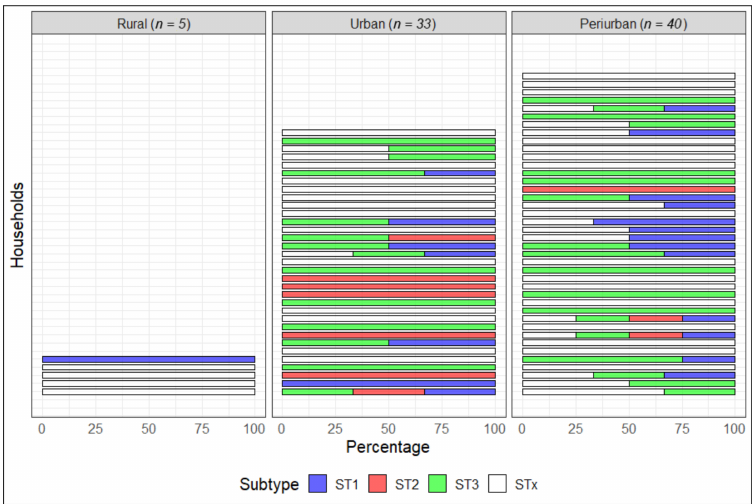
Figure 3. Distribution and composition of Blastocystis subtypes per household and study area. * STx: unknown Blastocystis subtype. n corresponds to the number of households that participated in each study area and not the number of participants. The samples came from 116 people from 78 households within 3